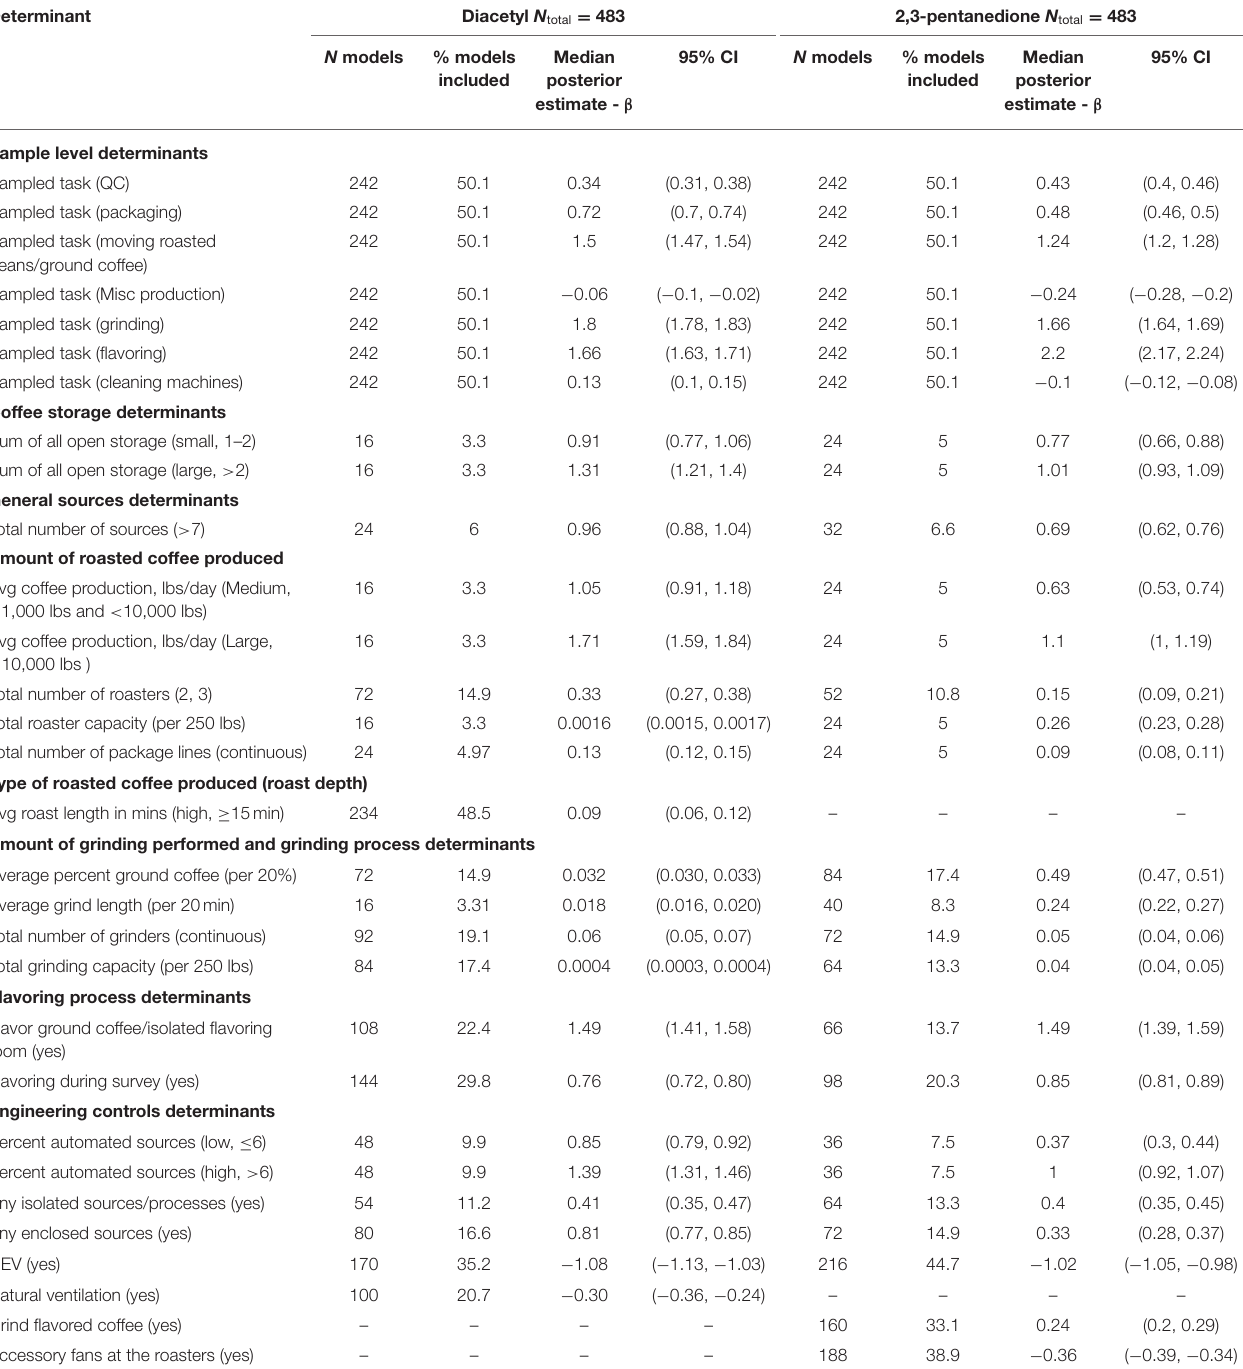
TABLE 2 | Bayesian model averaging results for diacetyl and 2,3-pentanedione exposures during all tasks (overall task model).